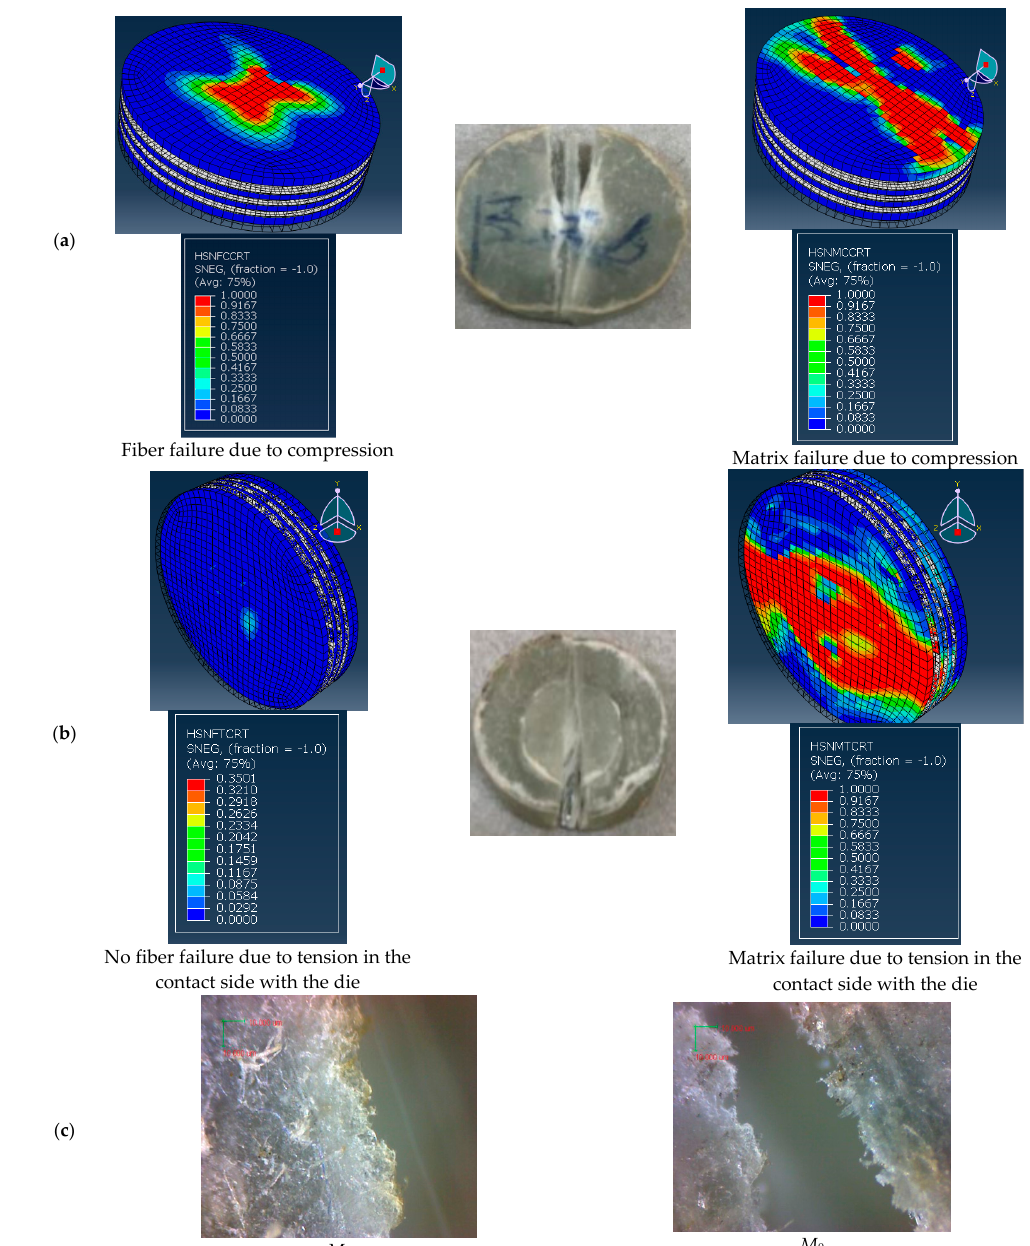
Figure 17. Experimental and numerical failure analysis of FGM specimens. ( a ) Layer opposite punch ( M 7 ), ( b ) Layer opposite punch ( M 7 ), ( c ) Scan of the specimen.